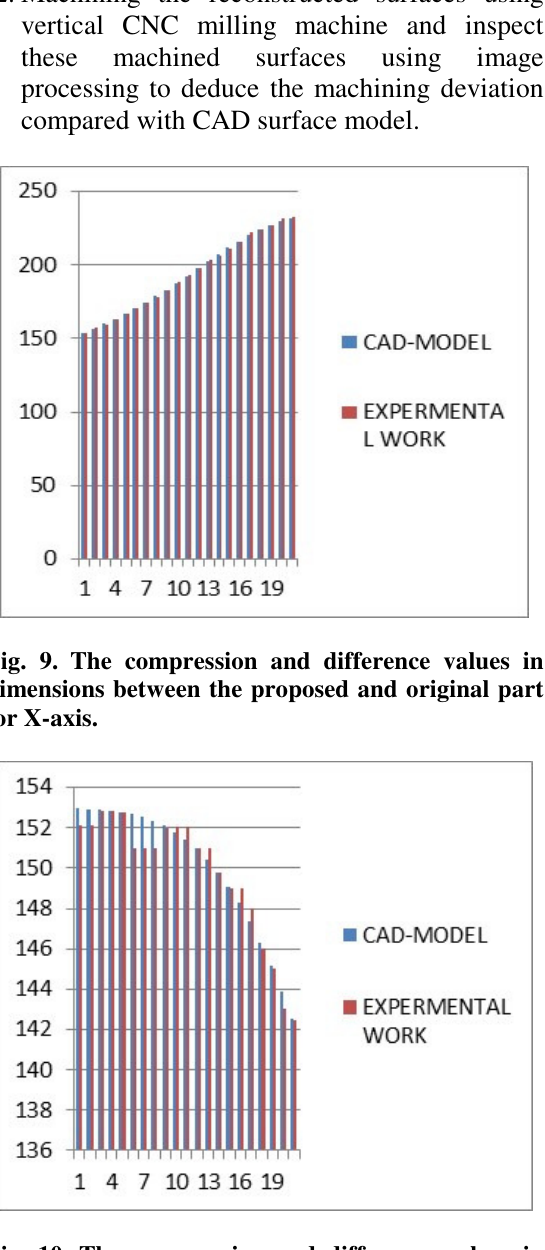
Fig. 10. The compression and difference values in dimensions between the proposed and original part for